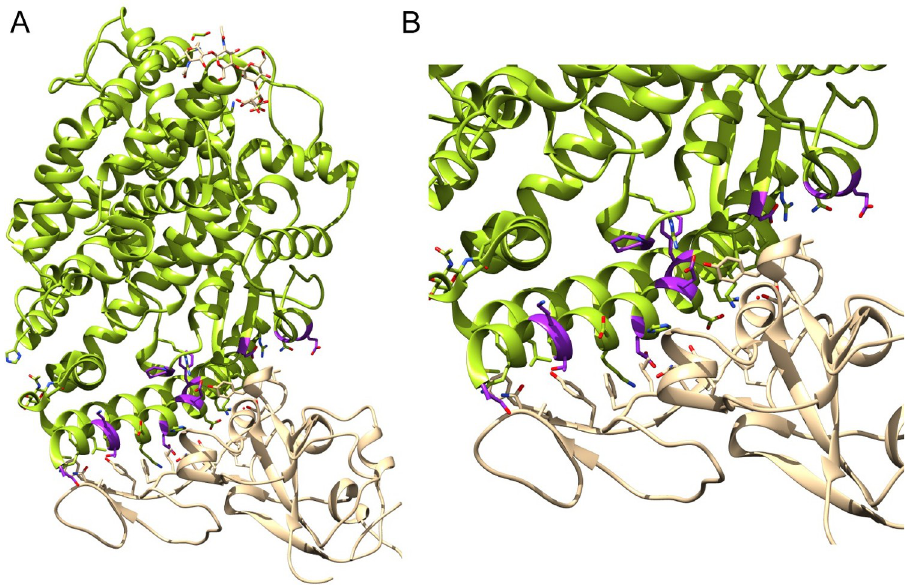
Fig 1. Binding affinity determination of ACE2 variants with SARS-CoV-2 Spike. A. ACE2 (green) in complex with Spike RBD (tan) from biological assembly 1 derived from PDB ID: 6vw1 [11]. The positions that were mutated in this work are highlighted magenta. B. The ACE2 Spike interface. Figure generated with Jalview [25] and UCSF Chimera [26].